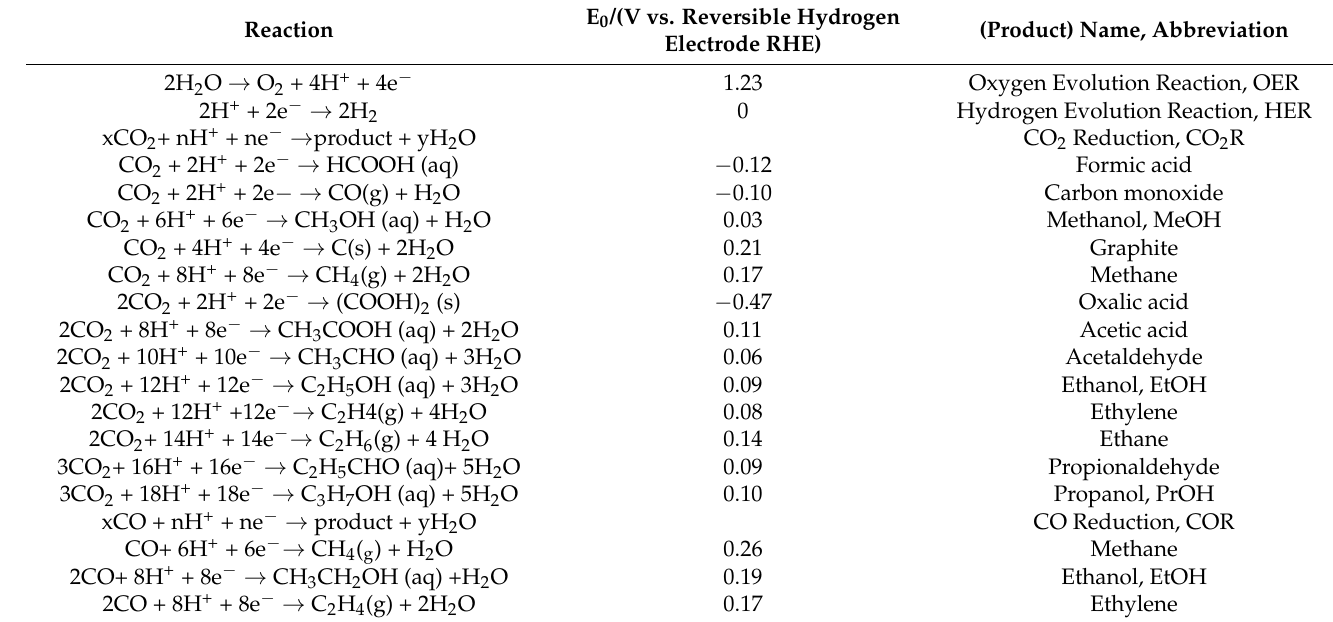
Table 1. Products of CO 2 ERR with equilibrium potentials. Reprinted with permission from [41] 2019, American Chemical Society. E 0 /(V vs. Reversible Reaction